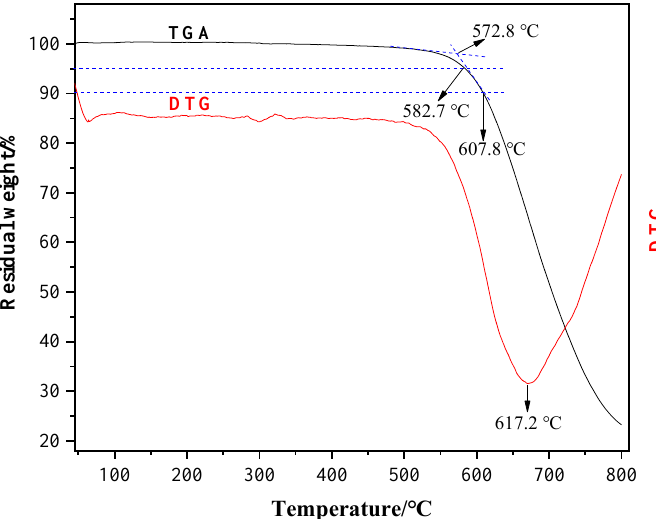
Figure 10. The TGA-DTG curve of the molded plate.